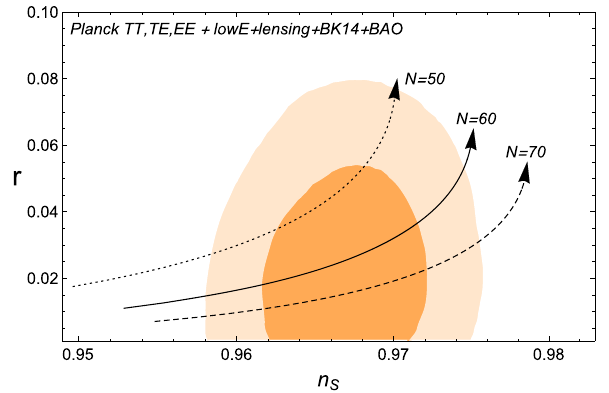
Fig. 4 TheparameterspacefromEq.(65)where κΛ (cid:9) 4 . 2418 × 10 − 3 . For the shaded region κ M ≤ 4 . 2 × 10 −